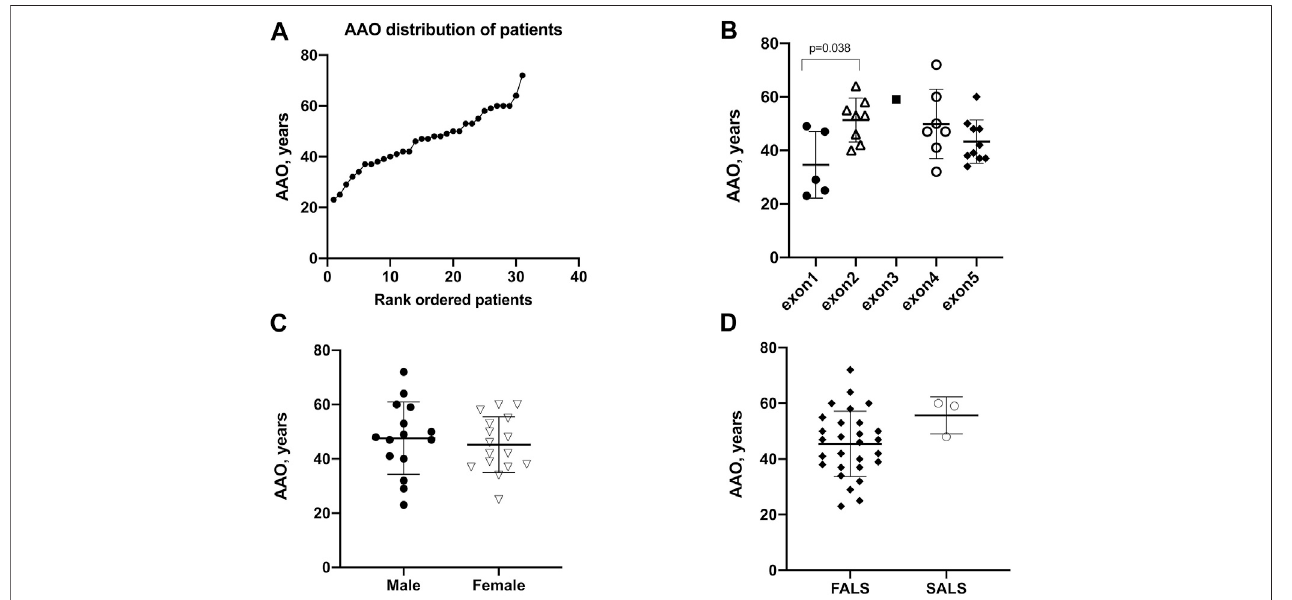
FIGURE 2 | Age at onset (AAO) of patients with SOD1 mutations. (A) Plot of rank ordered SOD1-mutant patients showing the median AAO of 47 years (B) Plot comparingtheAAOamongpatientscarryingmutationsindifferentexonsoftheSOD1gene.Patients( n (cid:1) 24)harboringmutationsinexon1wereolderthanthose( n (cid:1) 18)